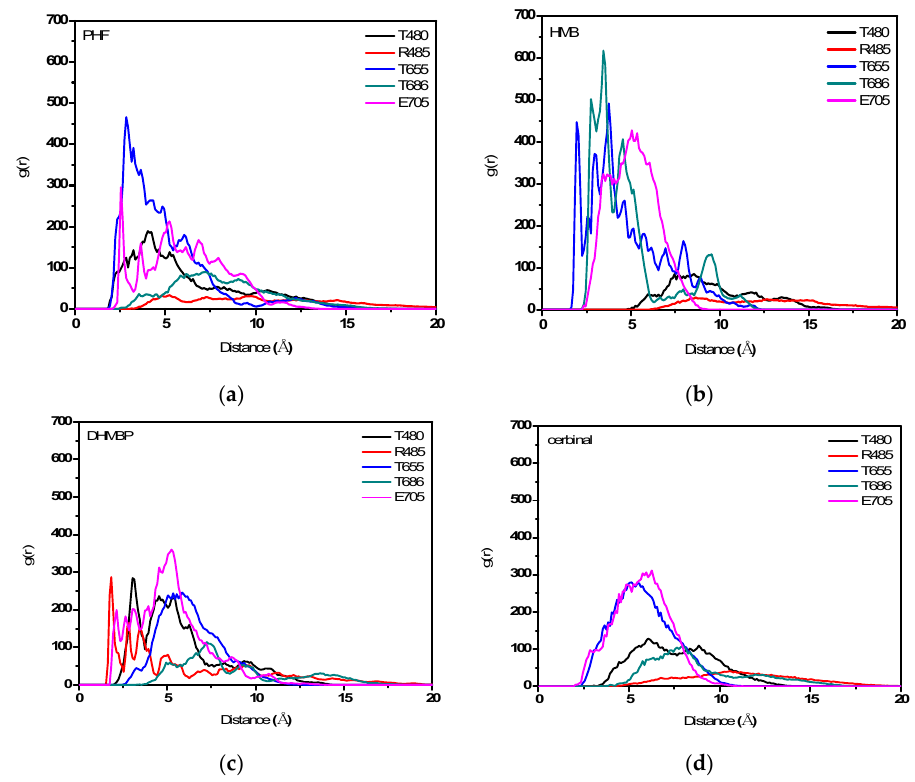
Figure 7. Radial distribution functions (RDFs) of ( a ) PHF; ( b ) HMB; ( c ) DHMBP; and ( d ) cerbinal with different residues. Black line: T480, red line: R485, blue line: T655, dark cyan line: T686, and magenta line: E705.